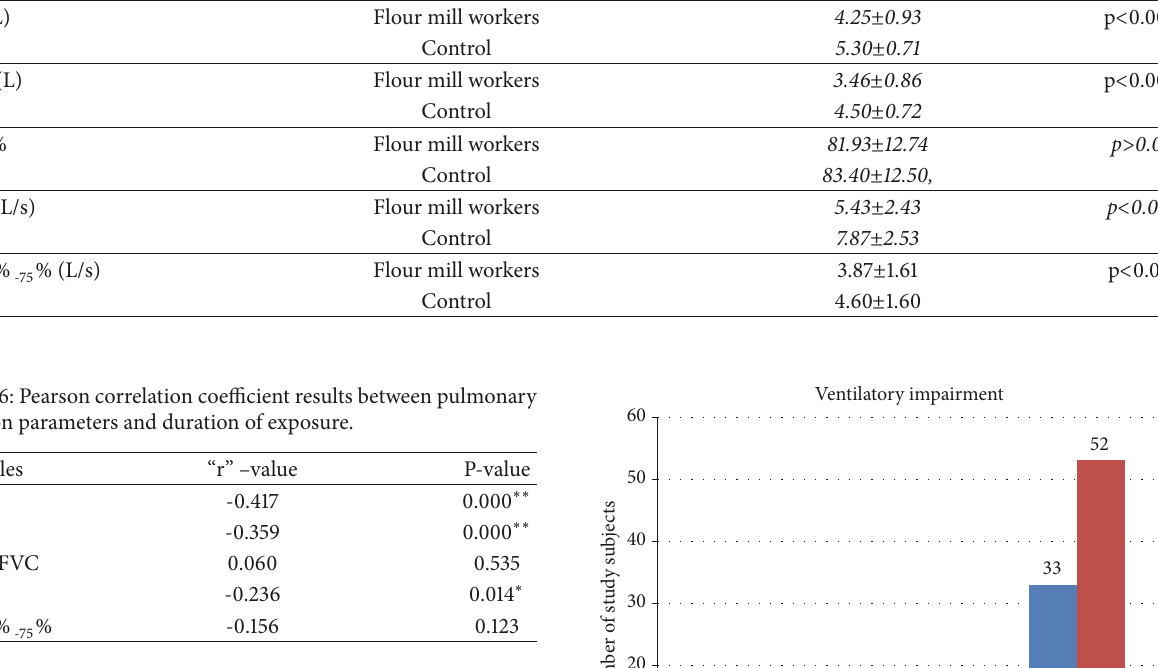
Table 5: The comparison of the actual value mean spirometric indices of exposed and nonexposed groups by independent sample t-test. PFTs Parameters